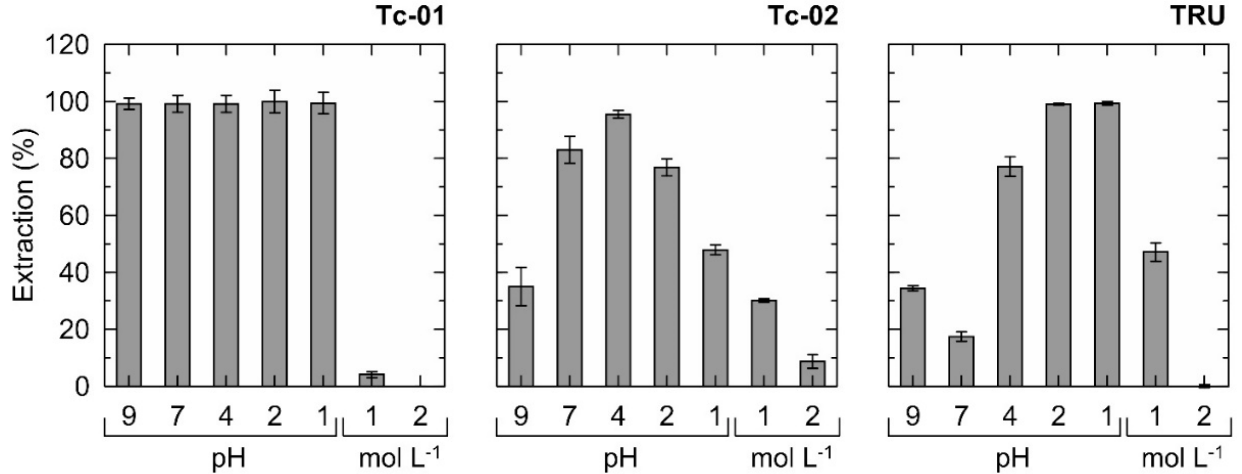
Figure 1. Effect of solution acidities on the Re extraction in the ECRs. Feed solution volume, 4 mL; C Re , 250 µg L − 1 ; solution pHs, 1 to 9; acid concentrations, 1 and 2 mol L − 1 HNO 3 ; sample loading flow-rates, 0.5 mL min − 1 ; n = 3.